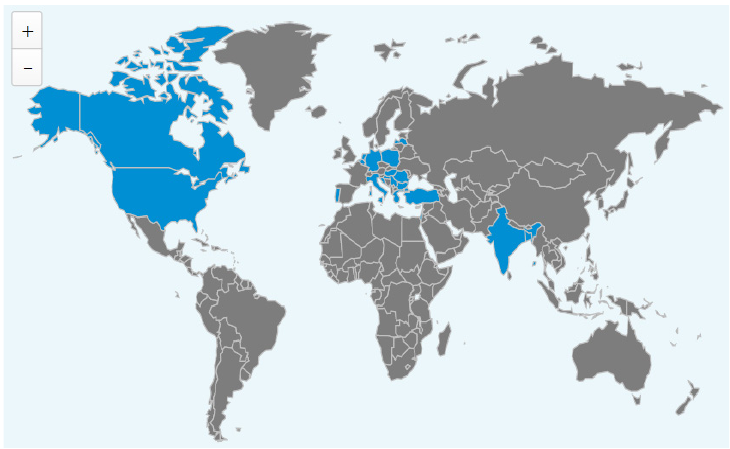
Figure 1. Response distribution (blue color represents respondents’ countries of origin). Source: QuestionPro Analytics.